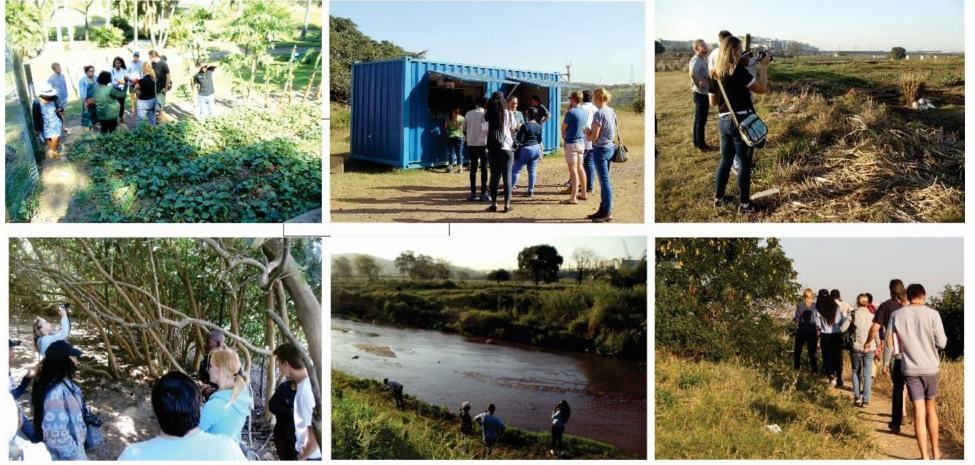
Figure 6. Meaningful field trip activities, such as site and case study visits, arranged by the municipal staff for the students during their visit to eThekwini. Source: Author,